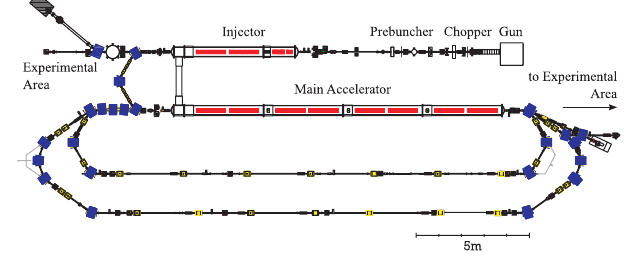
FIG. 1. (Color) Floor plan of